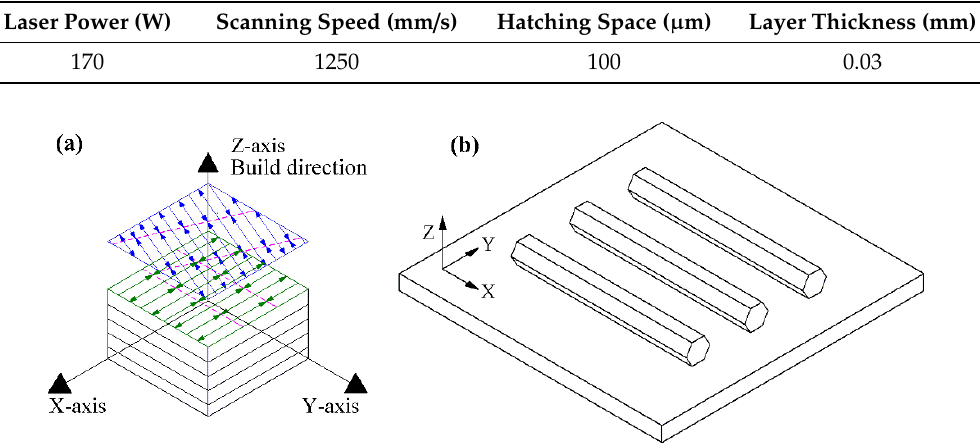
Table 2. Selective laser melting (SLM) processing parameters for Ti–6Al–4V samples.